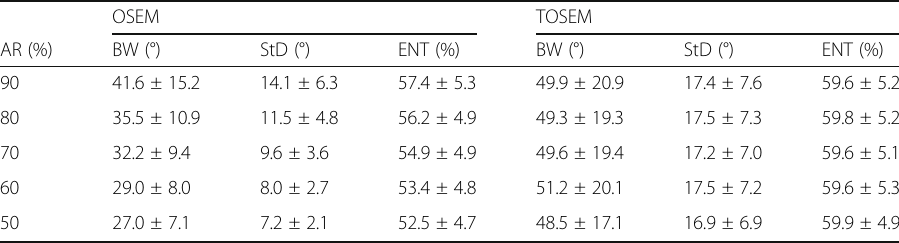
Table 1 Phase analysis results for patients whose unaltered activity ratio was > 90% OSEM TOSEM AR (%) BW (°) StD (°) ENT